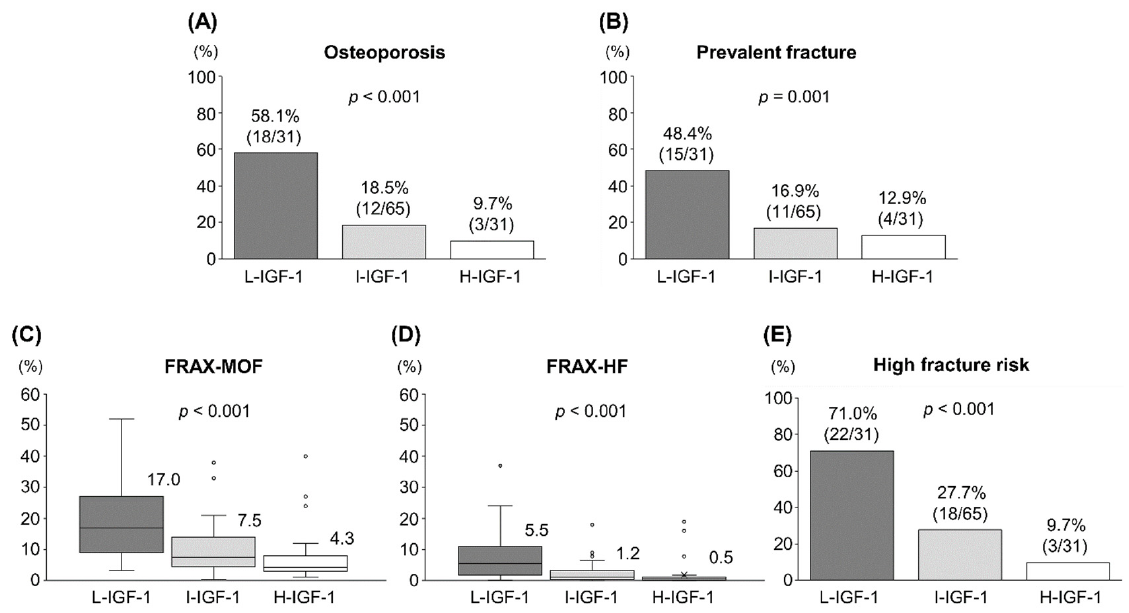
Figure 3. Clinical characteristics of the low-insulin-like growth factor 1 (L-IGF-1), intermediate-IGF-1 (I-IGF-1) and high-IGF-1 (H-IGF-1) groups. ( A ) The prevalence of osteoporosis significantly increased stepwise with decreasing serum IGF-1 levels. ( B ) The prevalence of prevalent fracture significantly increased stepwise with decreasing serum IGF-1 levels. ( C ) The 10-year probability of major osteoporotic fracture (FRAX-MOF) significantly increased stepwise with decreasing serum IGF-1 levels. The numbers on the upper right corner of each box indicate the median percentages in each group. ( D ) The 10-year probability of hip fracture (FRAX-HF) significantly increased stepwise with decreasing serum IGF-1 levels. The numbers on the upper right corner of each box indicate the median percentages in each group. ( E ) The prevalence of high fracture risk significantly increased stepwise with decreasing serum IGF-1 levels. FRAX, Fracture Risk Assessment